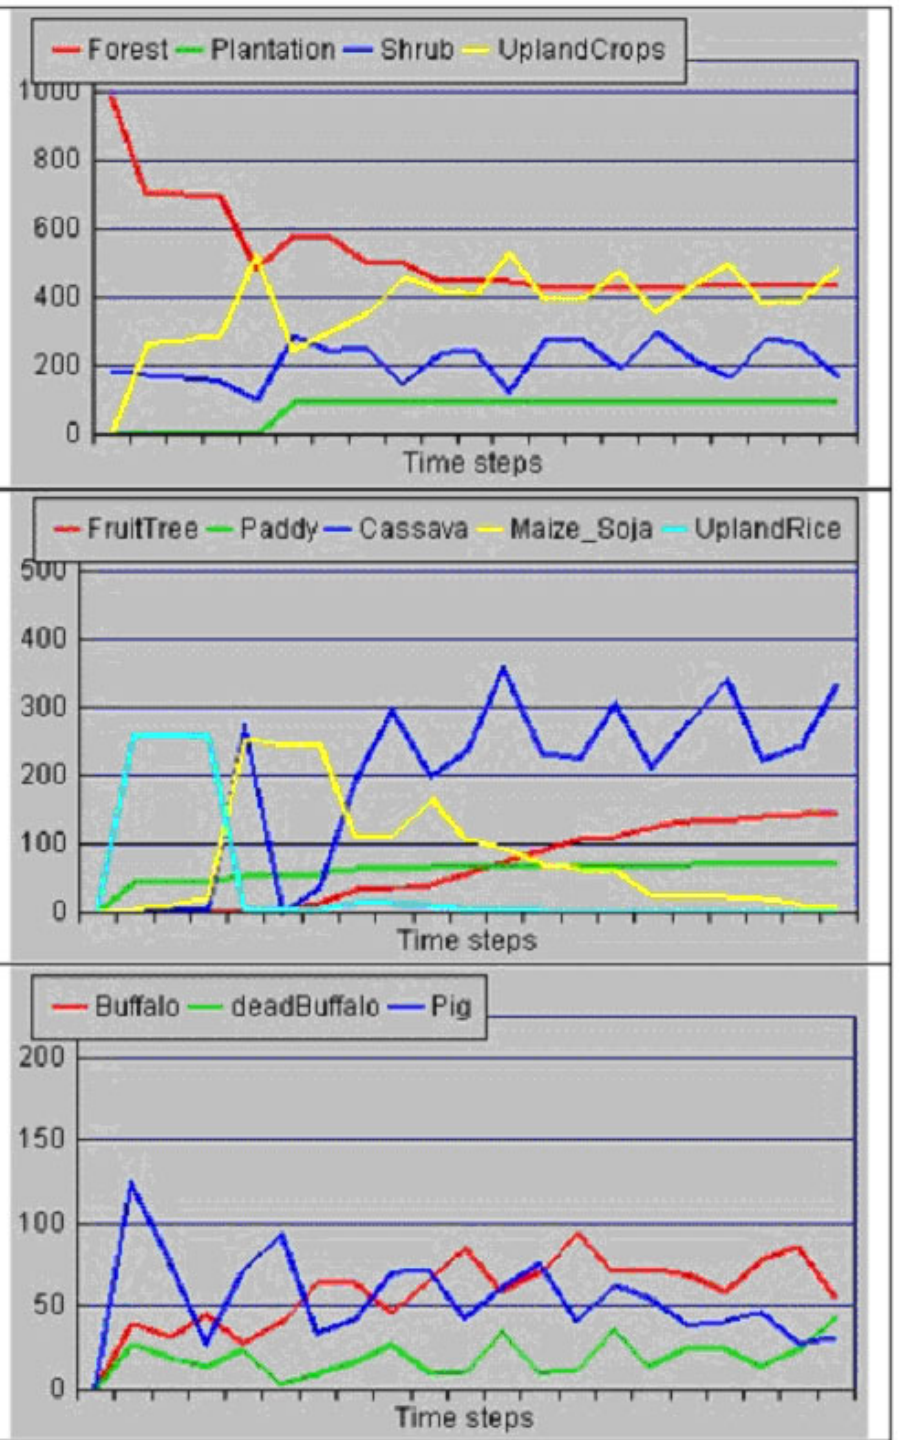
Fig. A2-3. Graphics representing the changes in land use and evolution of livestock herd of the whole community during a simulation with